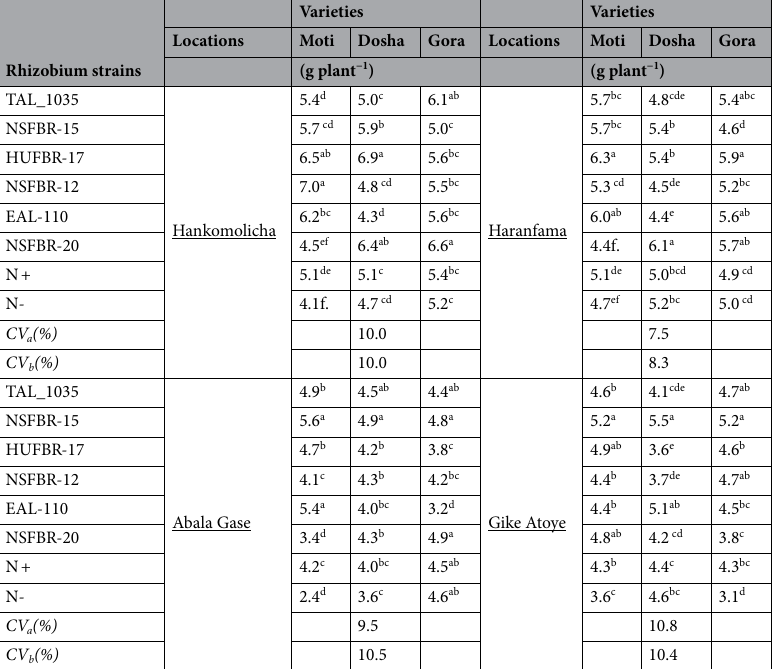
Table 8. Rhizobium strain x faba bean variety interaction effects on root dry weight at late flowering stage. Mean values in the same column with different letter(s) are significantly different at p ≤ 0.05 probability